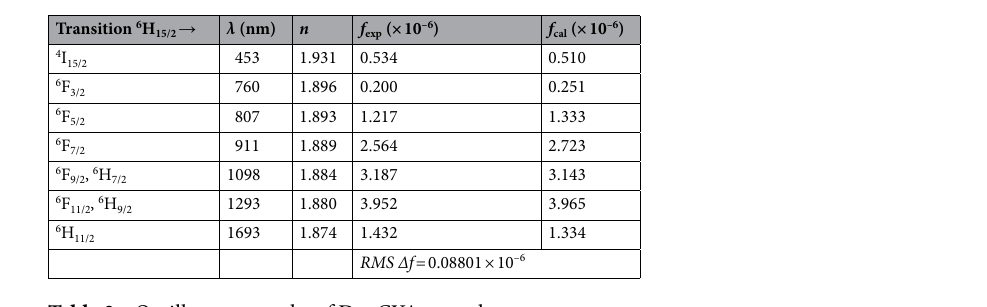
Table 2. Oscillator strengths of Dy: CYA crystal.